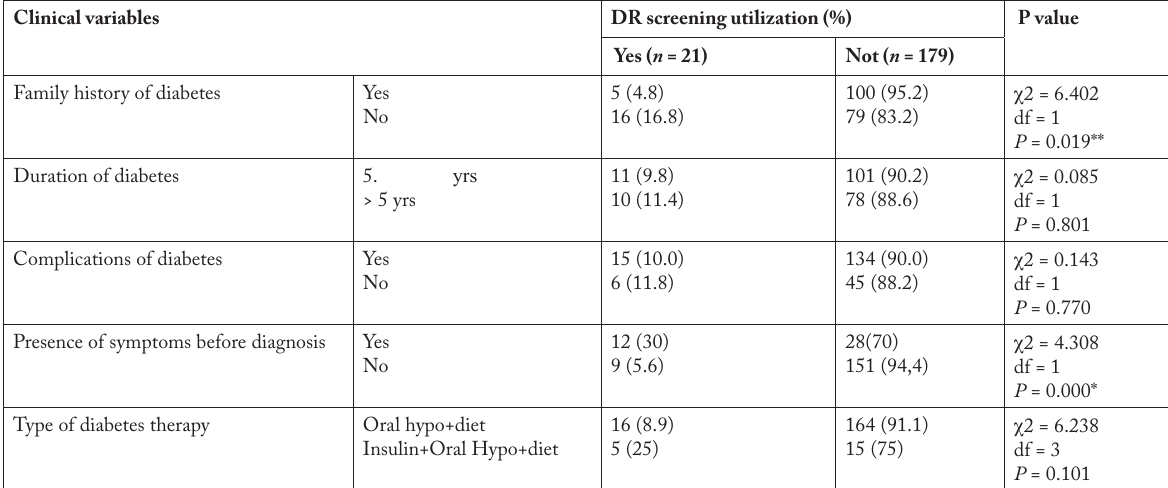
Table 5. Association between clinical factors and utilization of diabetic retinopathy screening amongst the partici- pants ( n =